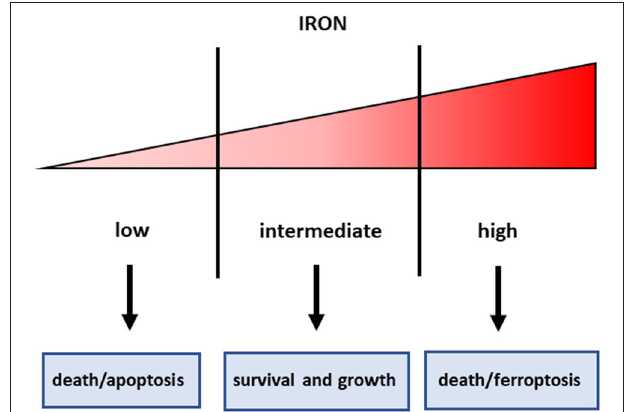
FIGURE 1 | Iron threshold concept. Certain iron levels are required for cell survival and homeostasis, but iron concentrations too low lead to apoptotic cell death, whereas excess iron equally triggers cell death.